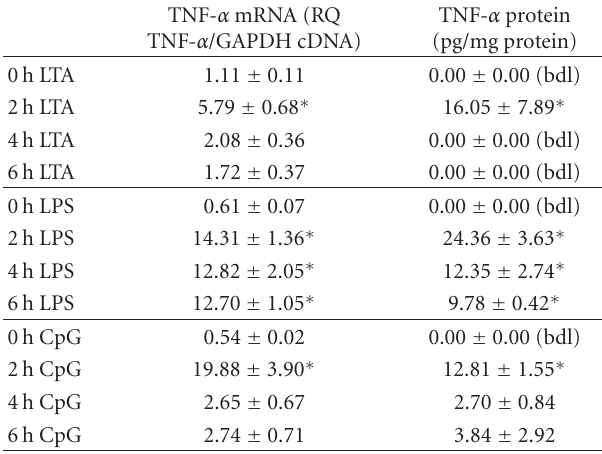
Table 1: TNF- α expression in the lung. Pulmonary TNF- α mRNA (RQ TNF-a/GAPDH cDNA) and TNF- α protein (pg/mg protein) expression 0, 2, 4, and 6h after LTA-, LPS-, and CpG-ODN- stimulation. Significant di ff erences to control values are indicated ( n = 4; ∗ P < . 05; bdl = below detection limit ; M ± SEM; n =